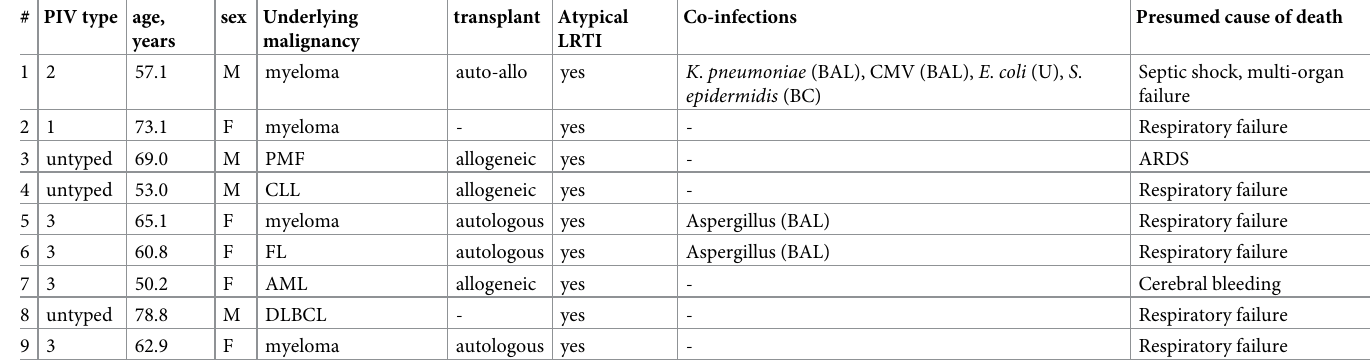
Table 2. Details on cases of fatal parainfluenza virus